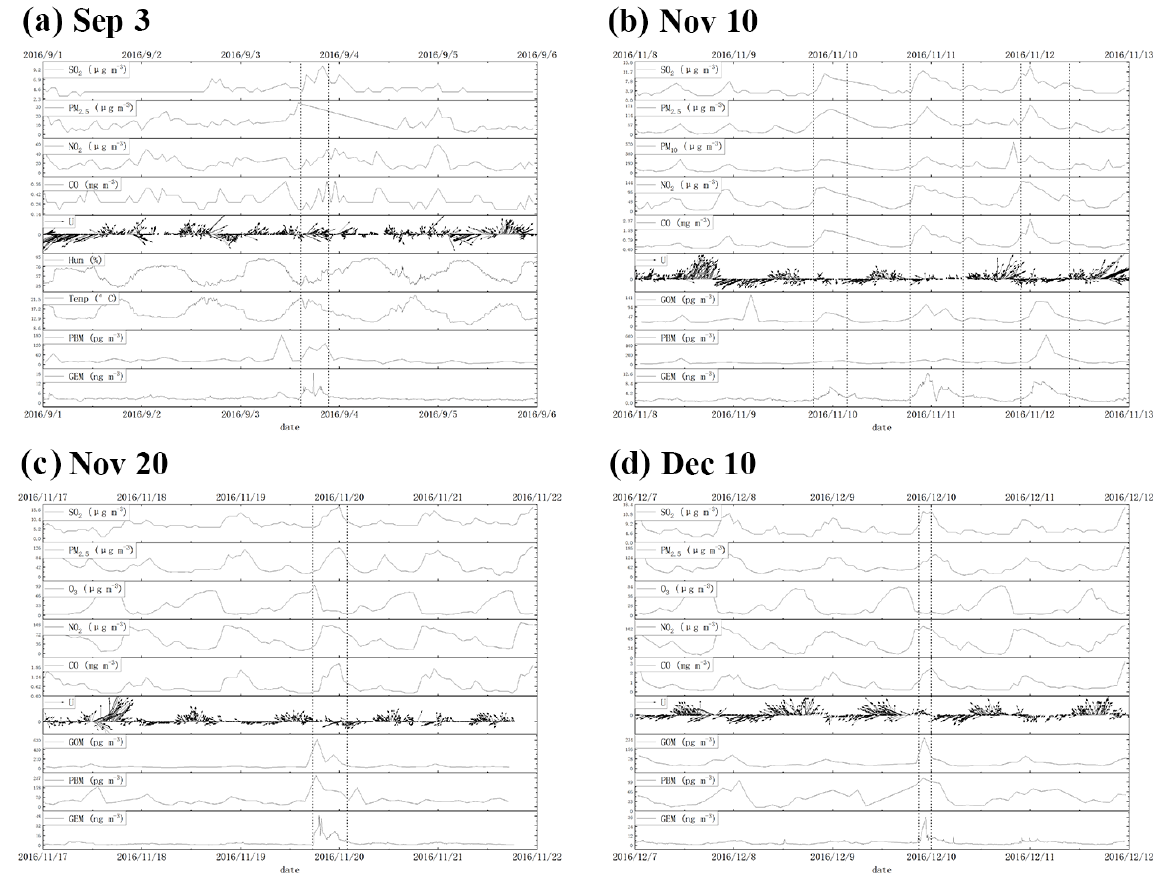
Figure 3. Comparison of the pollutant concentrations with those 2d before and after the events with high Hg concentration. The dotted lines indicate the area where the Hg concentrations are significantly